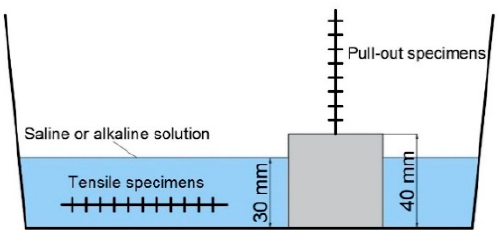
Figure 3. Conditioning exposure of tensile and pull-out specimens in saline and alkaline